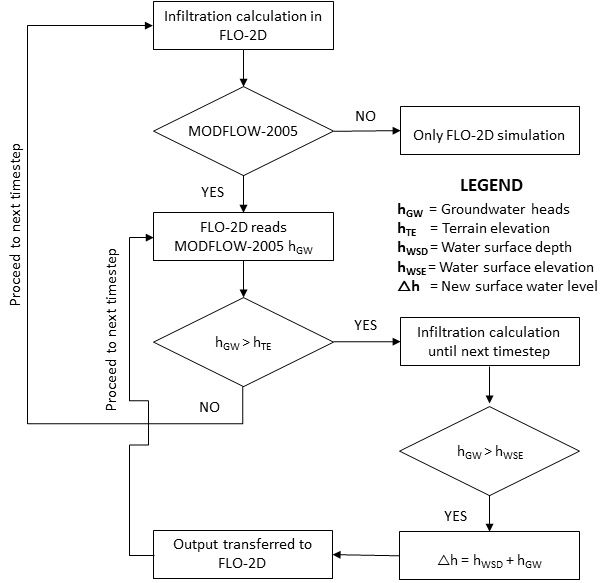
Figure 6. Conceptual diagram of the infiltration methodology in- corporated in the coupled FLO-2D and MODFLOW-2005 that il- lustrates the influence of groundwater heads in the infiltration cal- culation. Adapted from Nalesso